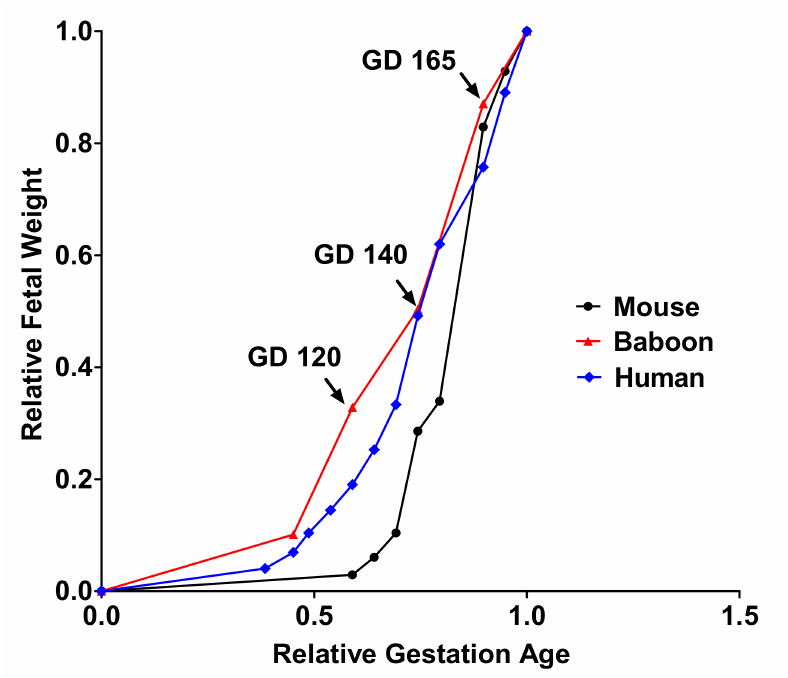
Figure 11. A timeline graph showing fetal growth curves for mice, baboons, and